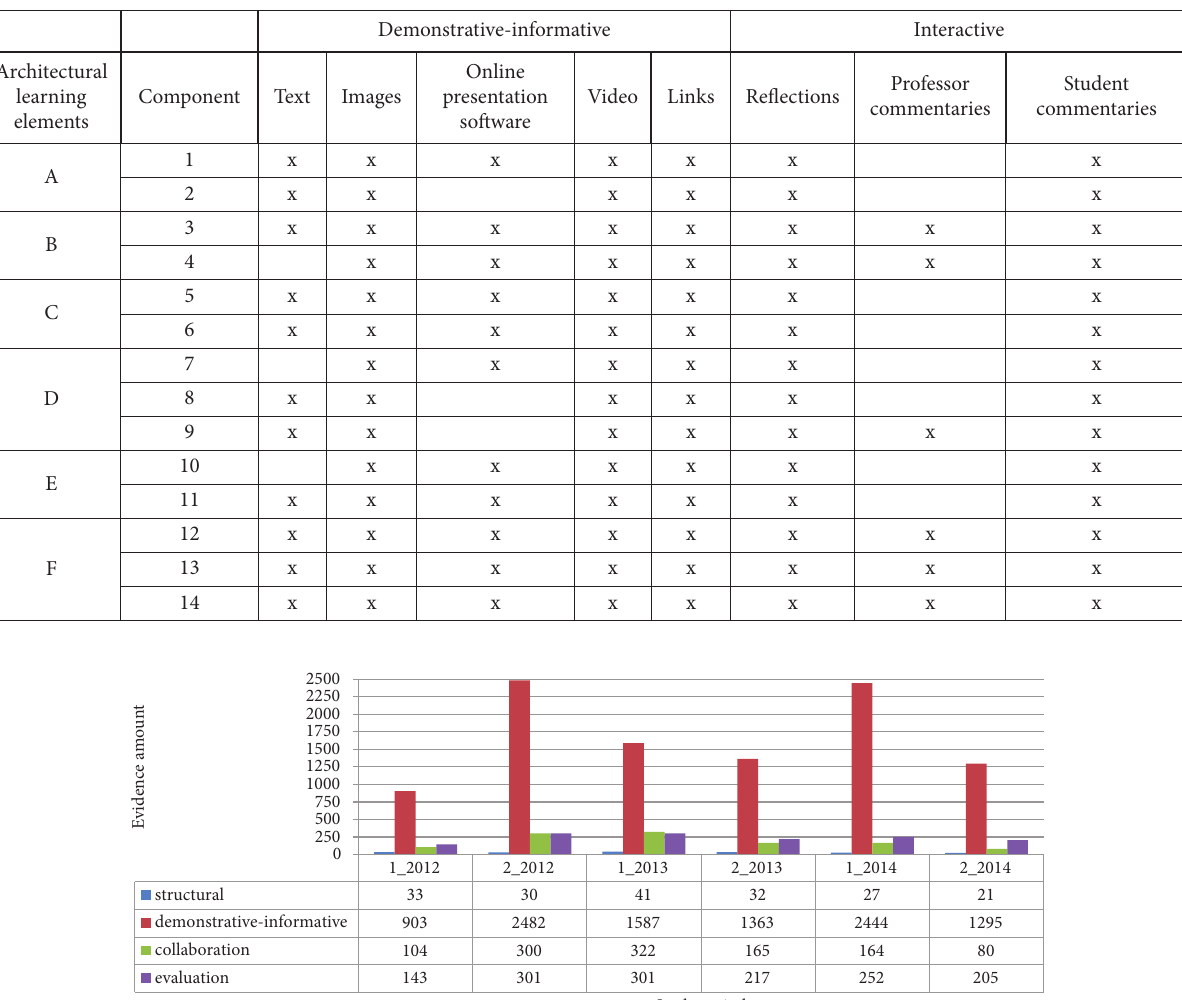
Table 6. Synthesis between the components and the evidences categories (source: Authors, 2019)